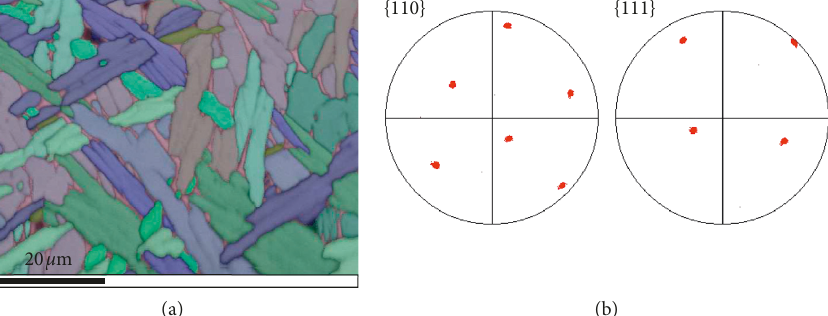
Figure 2: EBSD analysis of the α precipitates in the Ti-5.04Al/Ti-1.52Mo diffusion couple: (a) Euler orientation map; (b) pole figure of the β